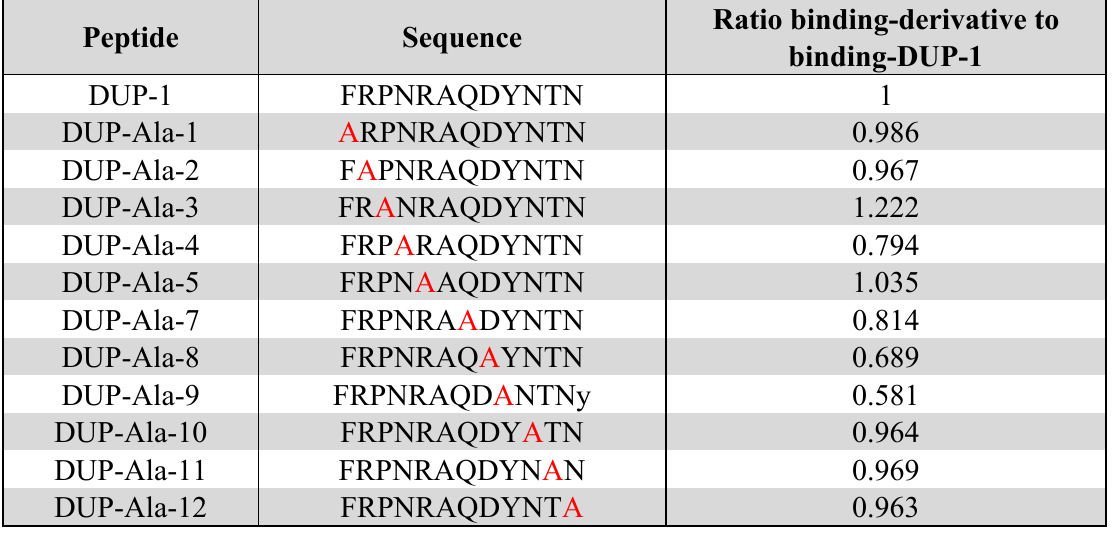
Table 3. Alanine scanning of DUP-1. Ratios binding-derivative to binding